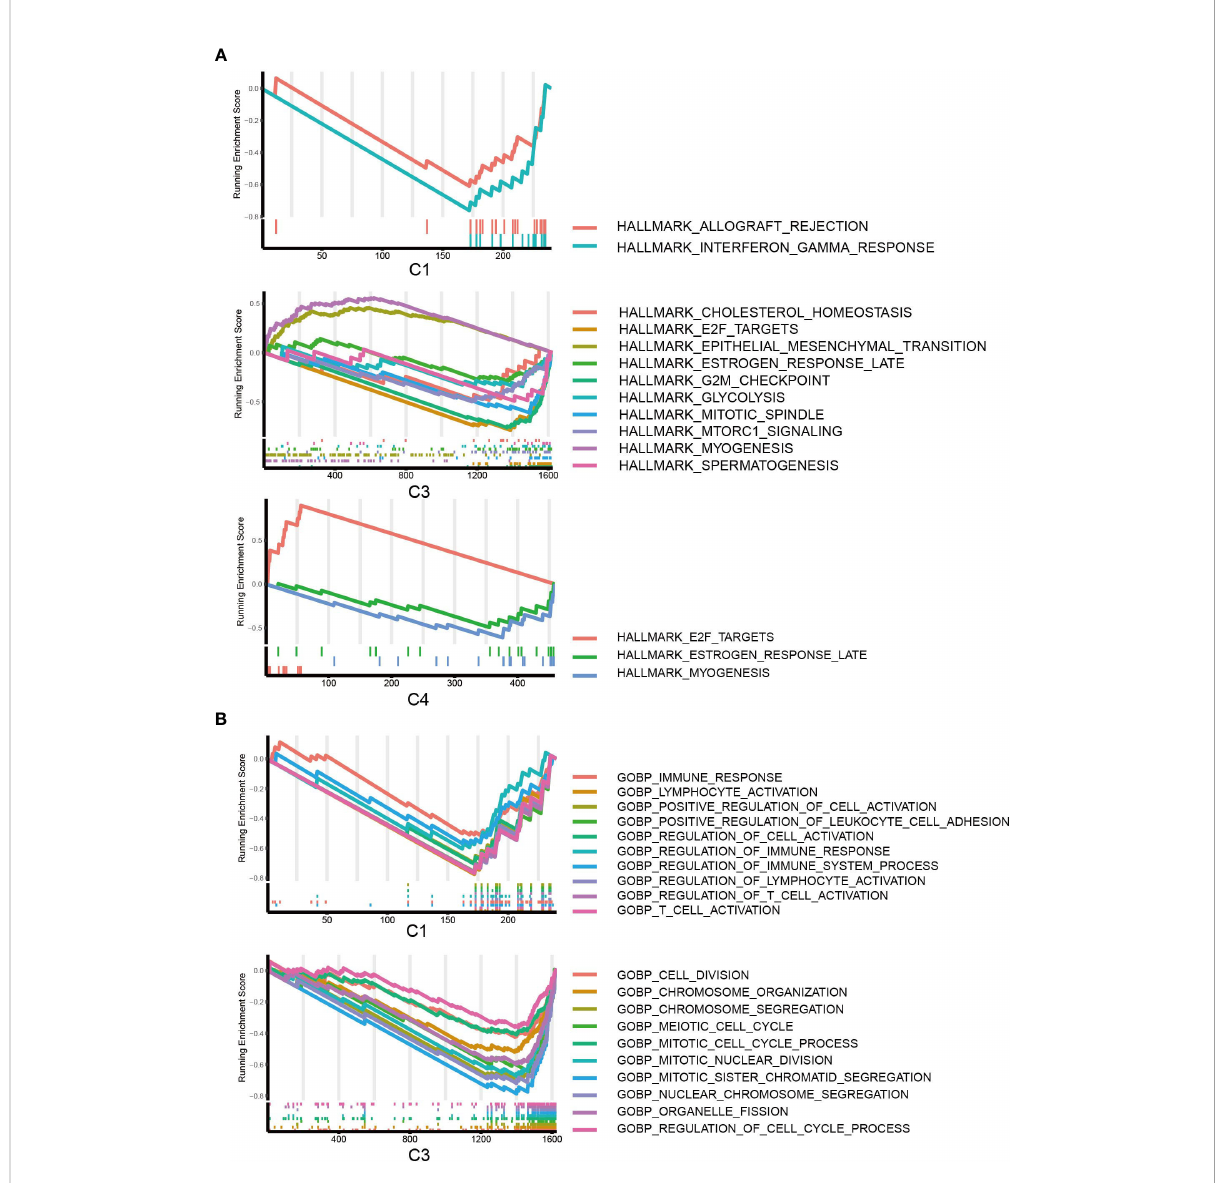
FIGURE 6 GSEA of DEGs. (A) GSEA of hallmark pathways for C1, C2 and C3; DEGs of C2 did not return with any pathways. (B) GSEA of GO pathways for C1, C3; C2 and C4 were not enriched for any GO